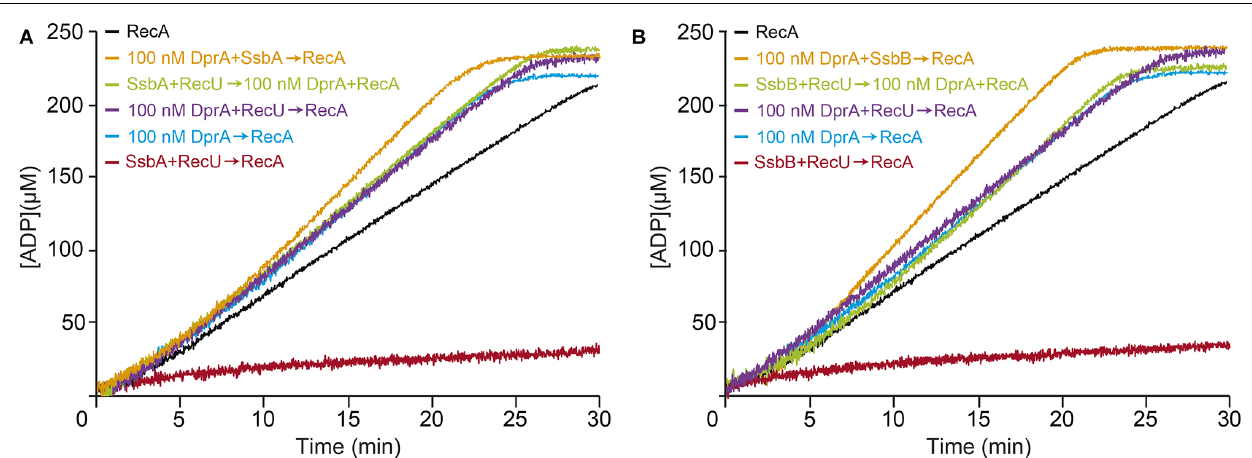
FIGURE 7 | DprA facilitates RecA filament extension on the RecU-ssDNA-SsbA or RecU-ssDNA-SsbB complexes. (A) Circular 3,199-nt ssDNA (10 µ M) was preincubated with SsbA (300 nM) and DprA or RecU (100 nM) (5 min, 37 ◦ C) in buffer B containing 5 mM ATP. RecA (0.8 µ M) or RecA and DprA were added, and ATPase activity was measured (30 min, 37 ◦ C). Black line, control reaction corresponding to an ATPase assay in the absence of mediators (RecA and ssDNA only). (B) A similar reaction was performed adding SsbB (300 nM) was added instead of SsbA. The amount of ATP hydrolyzed was calculated. Representative graphics are shown here and quantification of the results are expressed as the mean ± SEM of > 3 independent experiments (see Table 2 ).